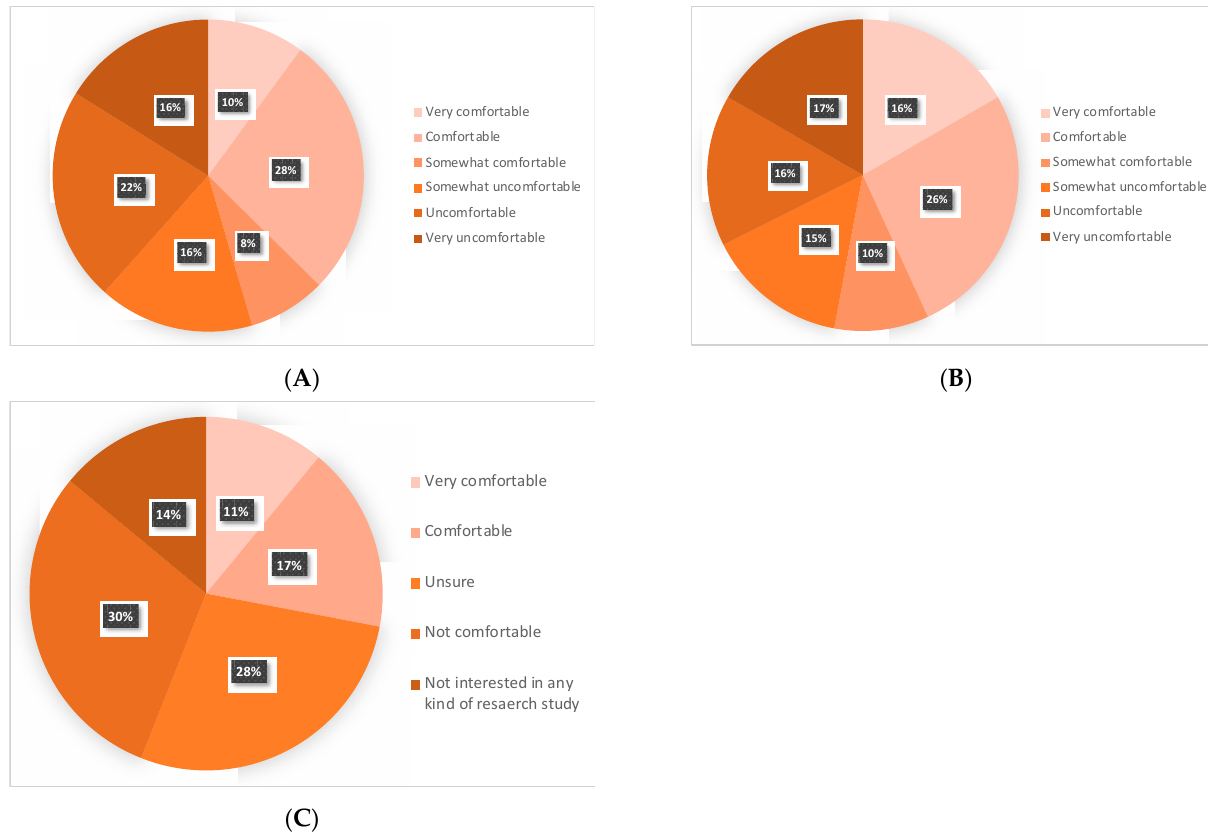
Figure 2. Attitudes toward omitting radiotherapy, endocrine therapy and participating in a de-escalation study: ( A ) omitting radiotherapy; ( B ) omitting endocrine therapy; ( C ) de-escalation study that omits endocrine therapy.